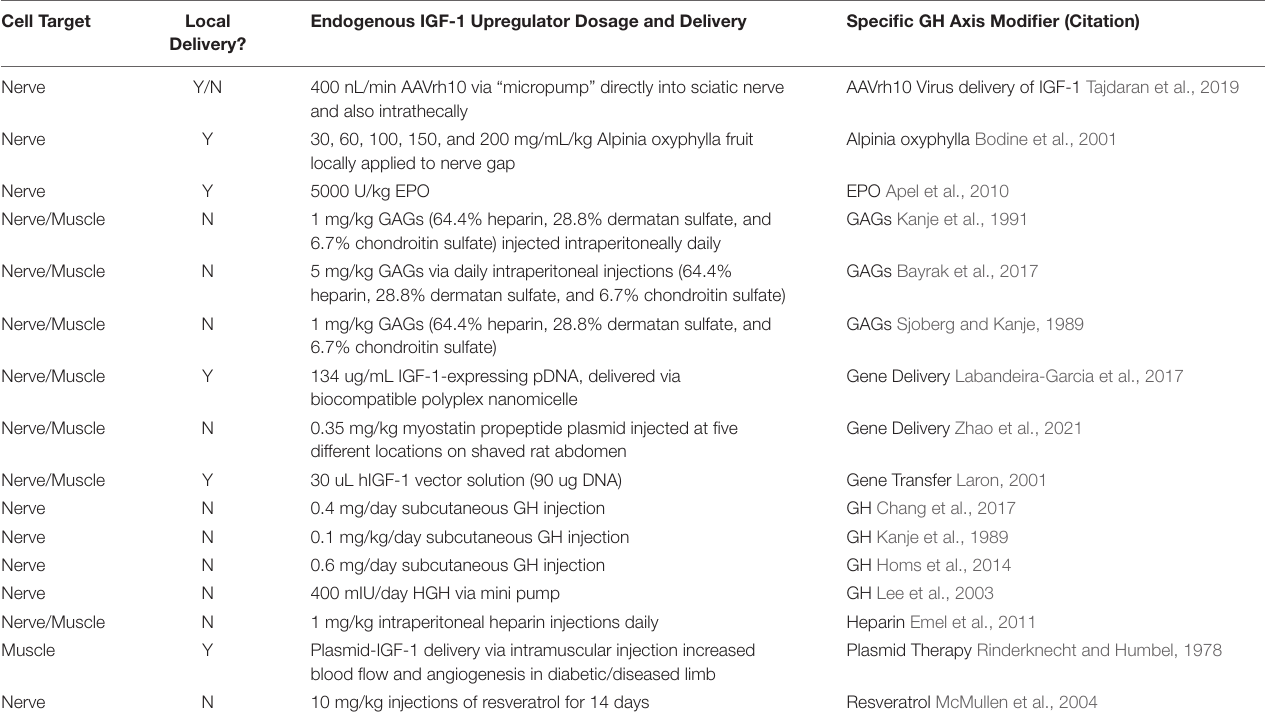
TABLE 2 | In vivo studies using upregulators of endogenous IGF-1 (AAVrh, adeno-associated virus rhesus isolate; EPO, erythropoietin; GAGs, glycosaminoglycans; pDNA, plasmid DNA; hIGF-1, human IGF-1; GH, growth hormone; HGH, human growth